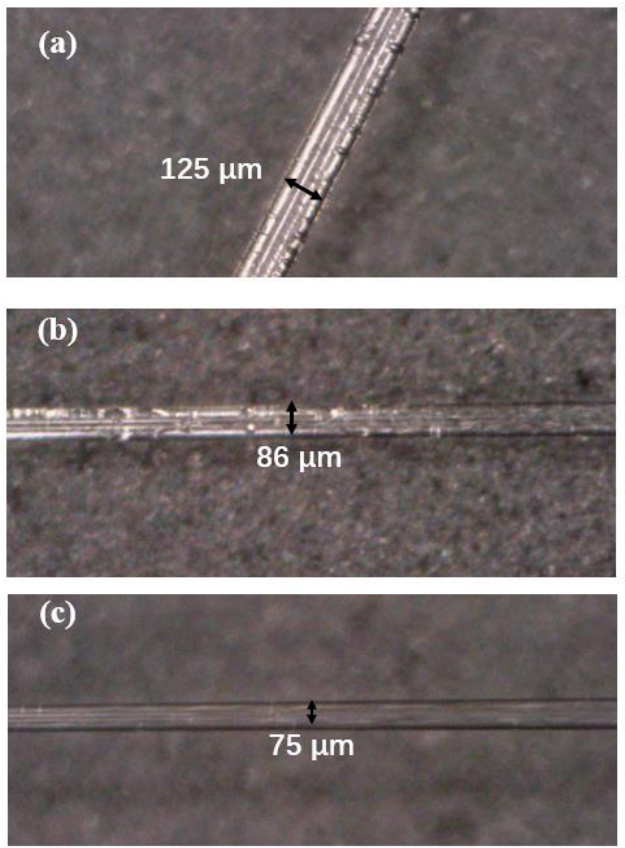
Figure 2. Microphotographs of different structures of the taper-shaped FBG, ( a ) with 125 µm waist ( b ) with 86 µm waist. ( c ) with 75 µm waist.